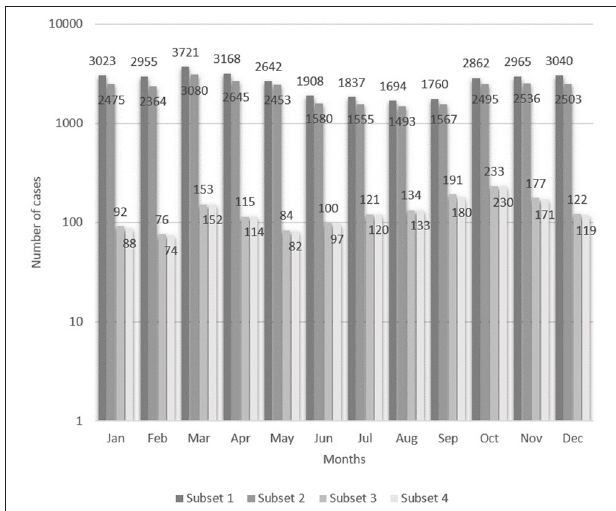
FIGURE 2 | Number of cases for each month of potentially severe convection based on the criteria defined in Table 2 for the four subsets over the area extending from 20 ◦ S to 10 ◦ N and 80 ◦ W–40 ◦ W and for the period